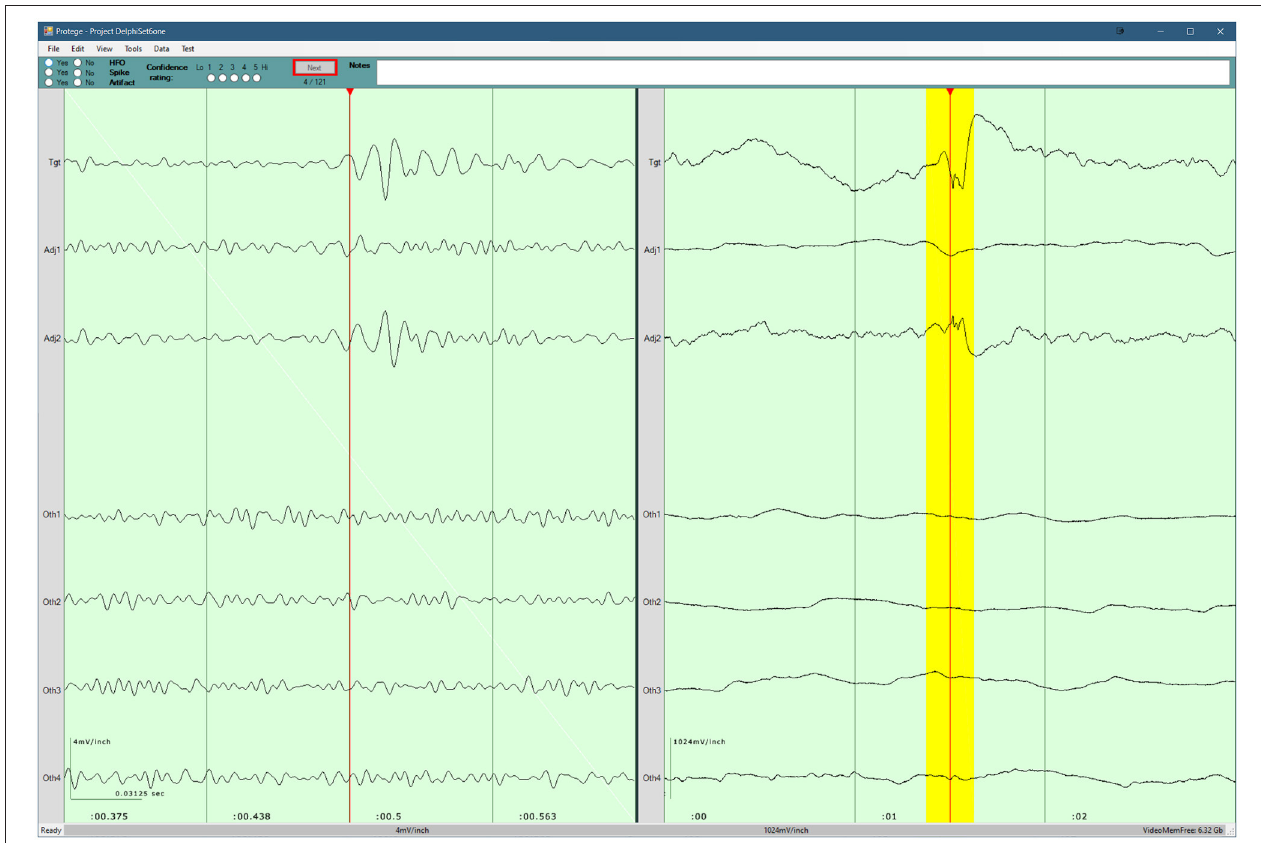
FIGURE 3 | Screenshot of the program used for the visual review component of the study. Three seconds of raw data are shown in the right pane. 250ms of filtered data are shown in the left pane, and the corresponding raw data are highlighted in yellow. The top pane contains the evaluation form for the current epoch, as well as the current progress. A detailed description of the evaluation program is available in our previous work